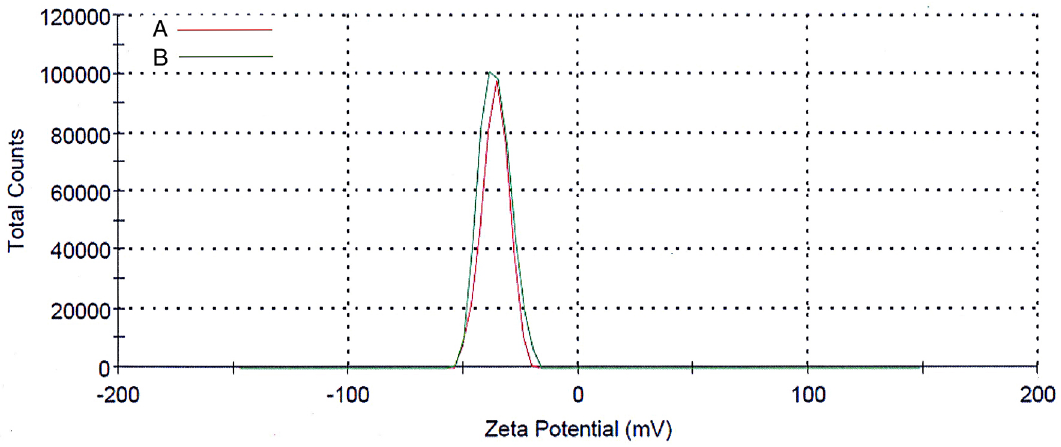
FIGURE 2 - Zeta-potential placebo and M-PEGNC. (A) Placebo B-PEGNC; (B)